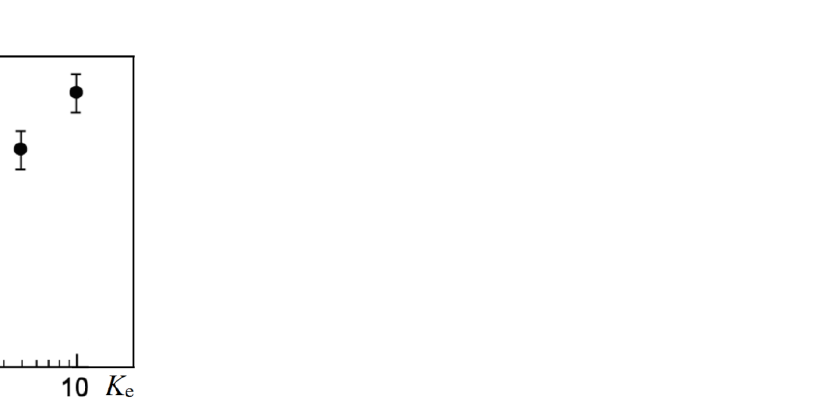
Figure 7. Influence of the extrusion ratio on the ultimate bending strength of Bi 0.91 Sb 0.09 crystals. The value of K e = 1 corresponds to single-crystal samples. Test temperature was 80 K. Table 3. Bending strength of extruded Bi – Sb polycrystals depending on the test temperature.